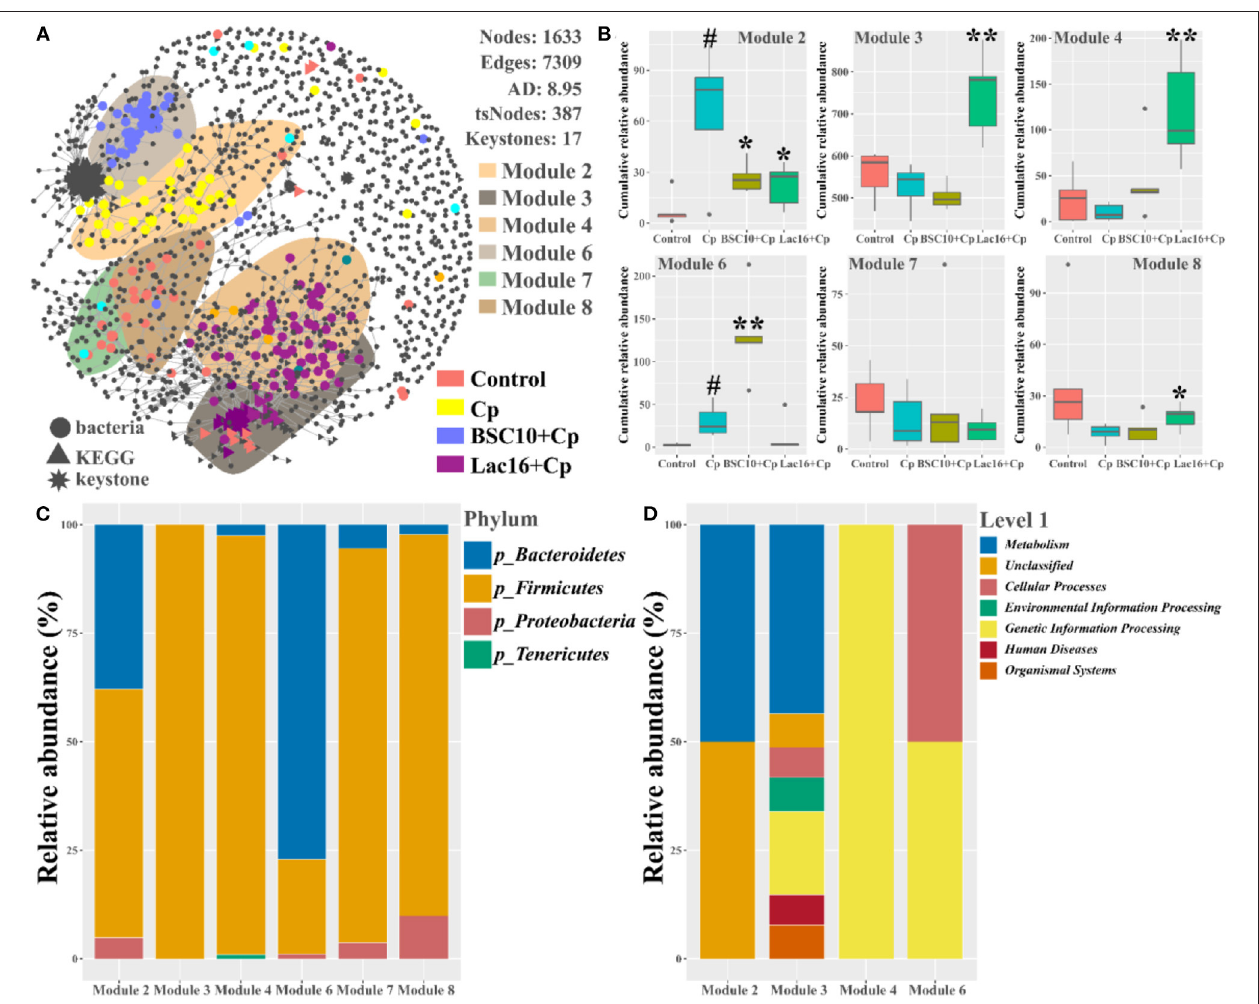
FIGURE 11 | Co-occurrence network of bacterial and metabolic functional communities. (A) Significant and close (| ρ | > 0.8, p < 0.05) correlations among bacterial OTUs and metabolic KOs are visualized in the network with gray lines. The bacterial, metabolic functional, and keystone nodes are indicated by circles, triangles, and stars, respectively. Sensitive nodes are colored by their association with the treatments, and gray nodes are insensitive to the treatments. Shaded areas represent the top six modules with high proportions. (B) Cumulative-relative abundance (as counts per million, CPM; y-axis in × 1,000) of the bacterial OTUs metabolic KOs belonging to the responsive modules. (C) The bacterial phyla and metabolic functional compositions for each module. Significant differences versus Control group: # p < 0.05. Significant differences versus Cp group: * p < 0.05; ** p <